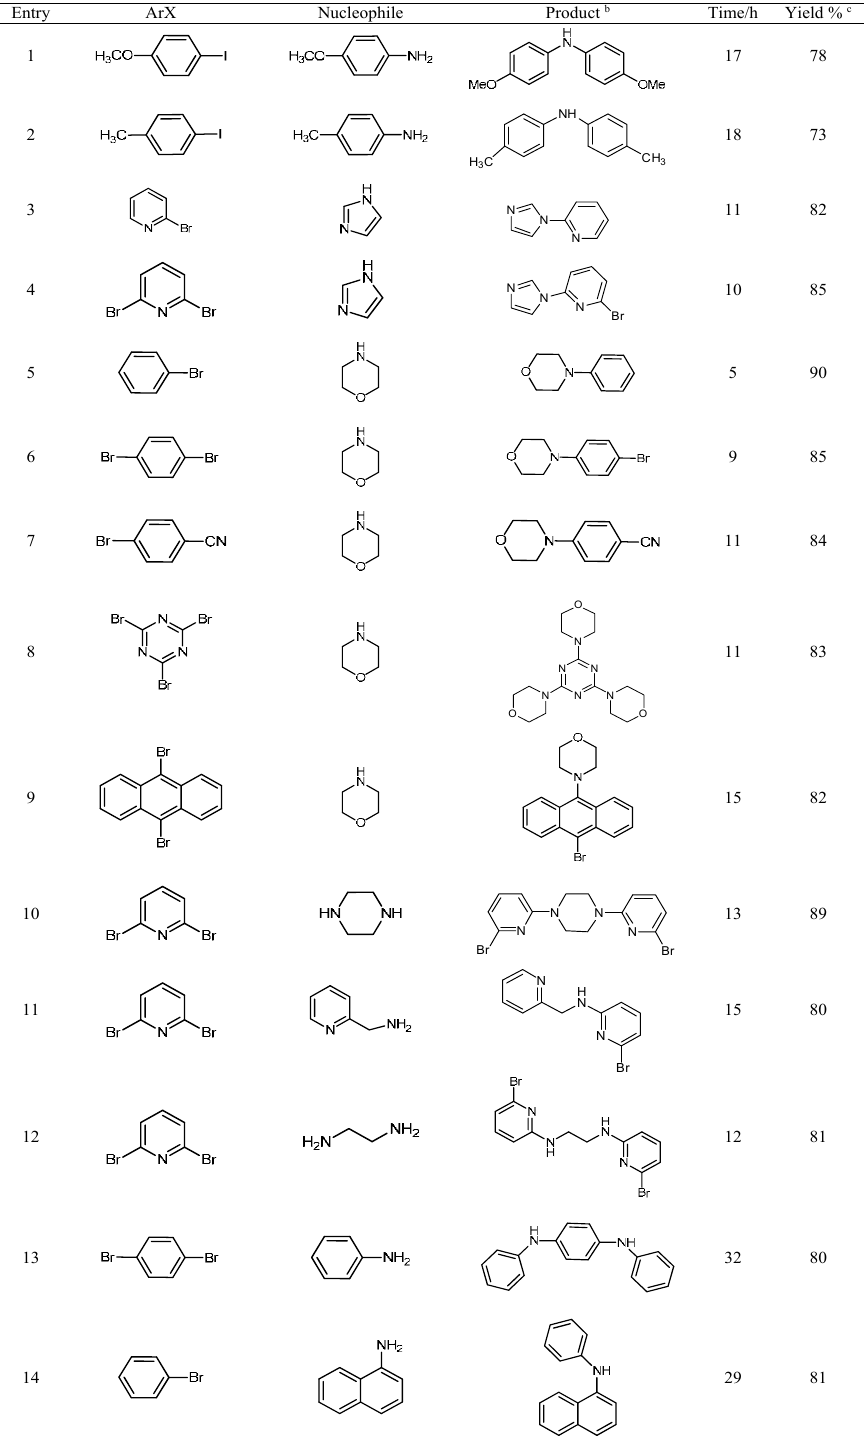
Entry ArX Nucleophile Product b Time/h